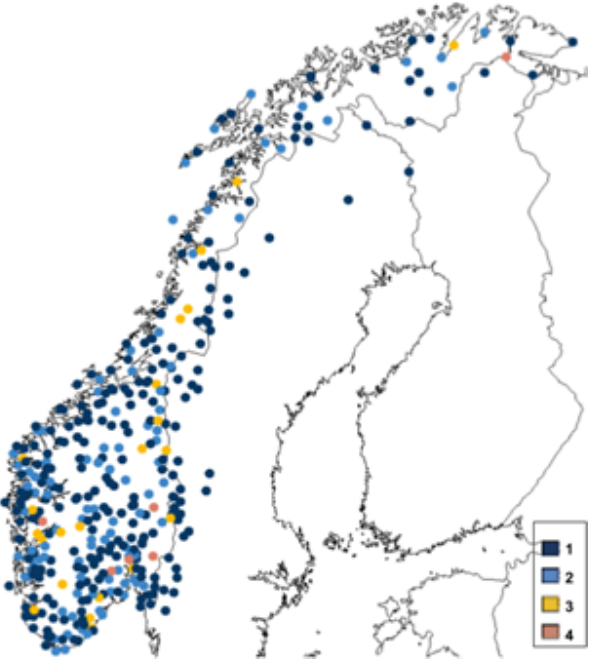
Figure 1. Location of stations used in the study. The colors denote if the series is merged and if so, how many series are included in the merged